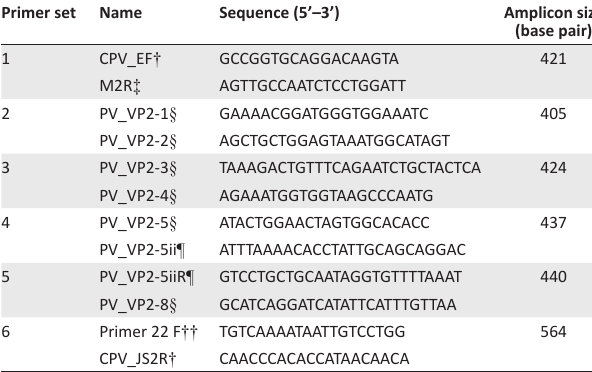
TABLE 2: Details of sequences and amplicon size of primers used in this study for polymerase chain reaction and sequencing spanning the viral capsid protein 2 gene region.